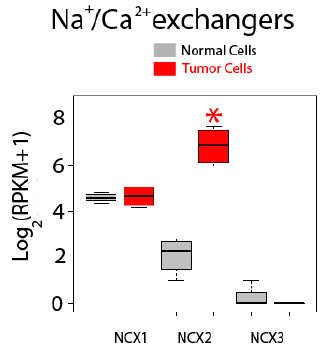
Figure 12. Expression of Na + /Ca 2+ exchanger isoforms in normal and colon cancer cells. Expression levels of NCXs in normal colonic cells (grey bars) and colon cancer cells (red bars). * p statistically significant by three independent methods.